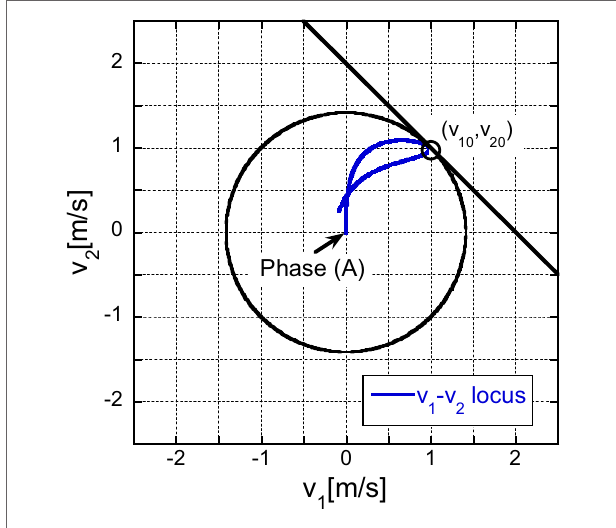
FigUre 17 | Velocity (first-story mass)-Velocity (second-story mass) plane for variable motion of masses attaining the maximum sum of momenta (tangential line) by the convex model and the actual motion of masses starting from the phase (a) (only the first impulse is